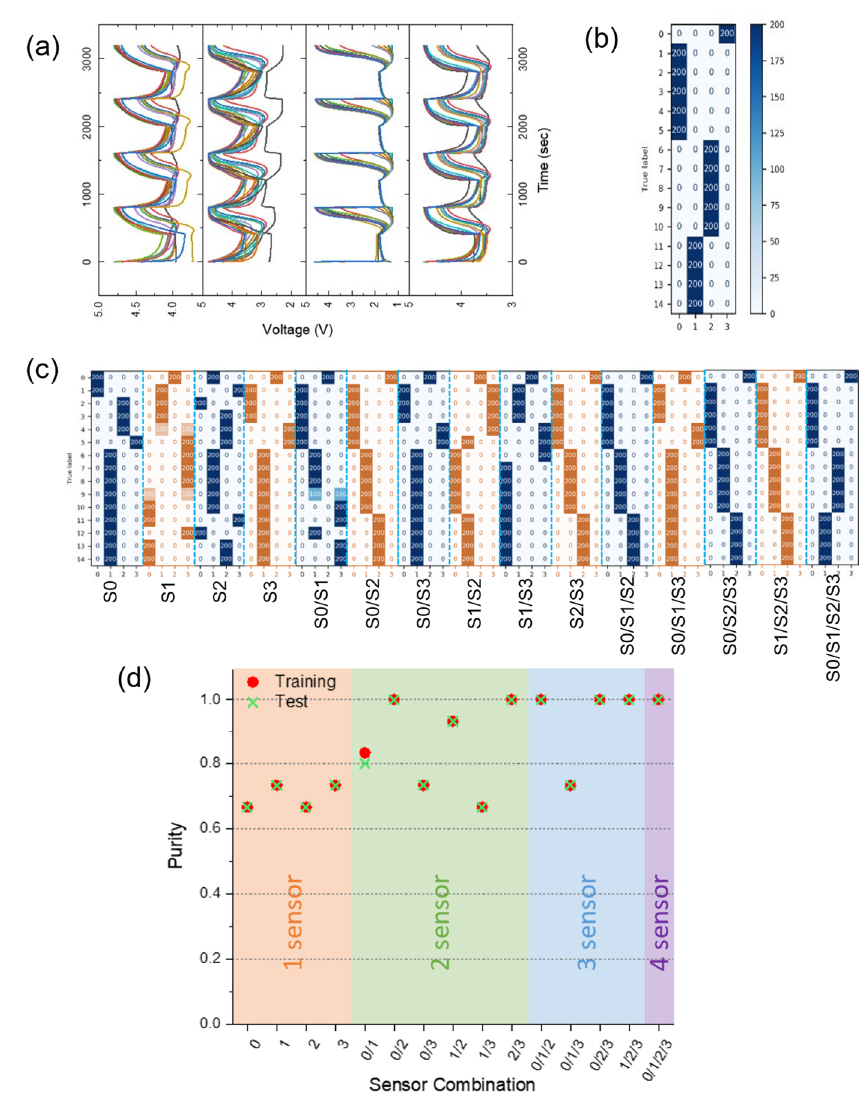
Figure 3. ( a ) Gas sensing data replotted as a function of gas mixture type, i.e., N 2 , CO, alcohol, and CO/alcohol; ( b ) example of cluster formation of 4 clusters obtained from a 4-sensor array combination; ( c ) cluster formation of 4 clusters as a function of sensor combination from 4 single sensors to a single 4-sensor mode; ( d ) purity information obtained from labeled gas combination sensor data from various sensor combinations using K = 4.